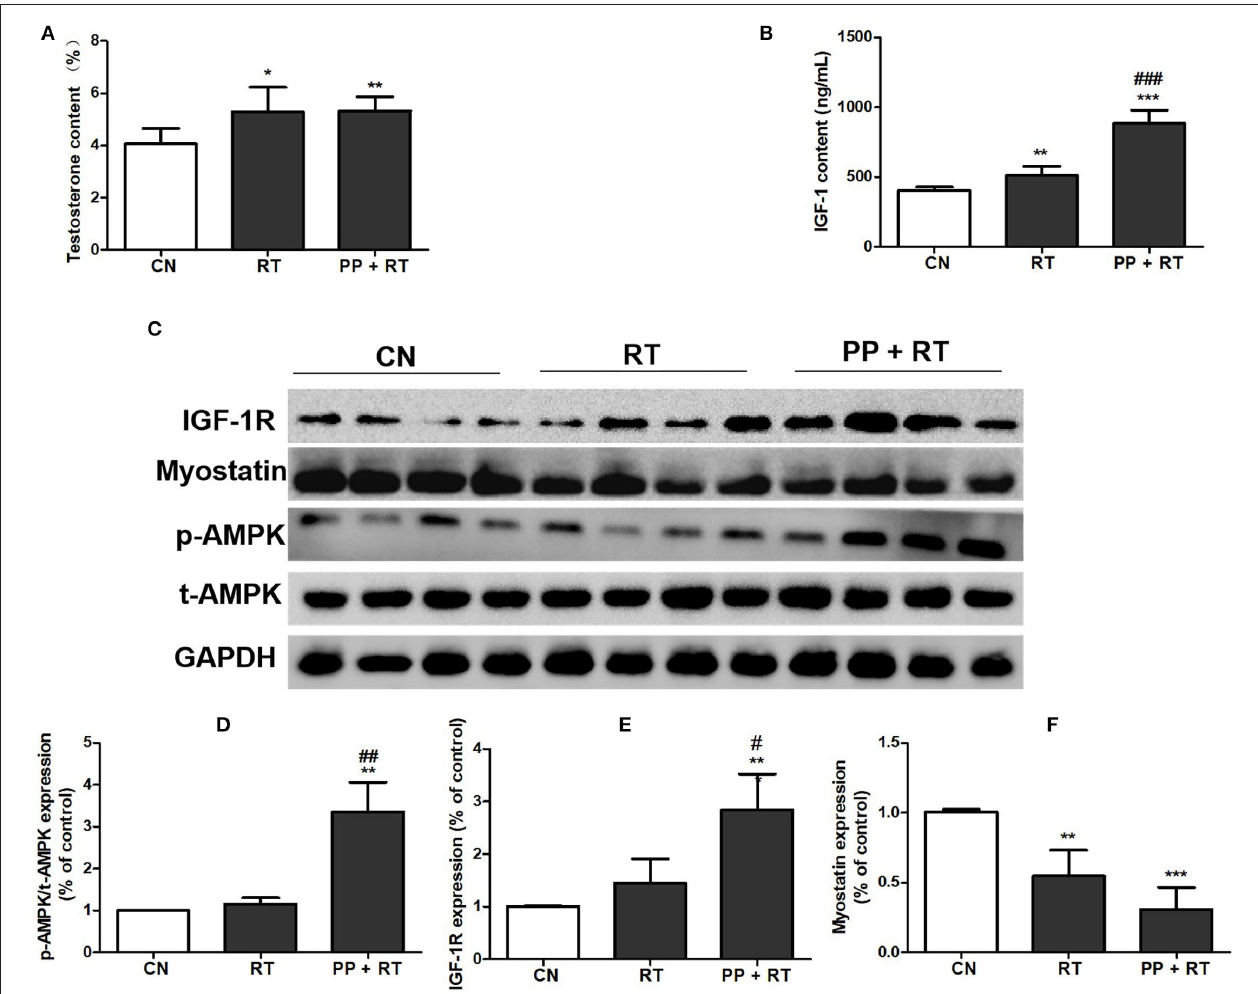
FIGURE 4 | Pea peptide supplementation activated muscle growth-signaling pathway. (A) Circulating testosterone content of the rats in CN, RT, and PP + RT group; (B) circulating IGF-1 content of the rats in CN, RT, and PP + RT group; (C) p-AMPK, t-AMPK, IGF-1R, and myostatin expression of skeletal muscle detected by western blots analysis; (D) statistical analysis of p-AMPK expression; (E) statistical analysis of IGF-1R expression; (F) statistical analysis of myostatin expression. CN: Control group; RT: resistance training group; PP + RT: pea peptide supplementation combined with resistance training. The significant difference between groups was validated with one-way ANOVA using GraphPad Prism 6, * p < 0.05, ** p < 0.01, *** p < 0.001 vs. CN group, and # p < 0.05, ## p < 0.01, ### p < 0.001 vs. RT group ( n = 5/group). Data are presented as mean ± standard deviation (M ±